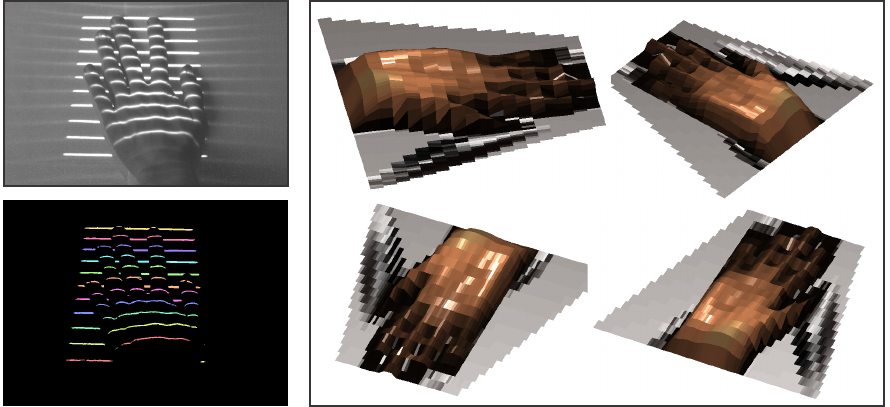
Figure 18. A visual example of the 3D reconstruction capabilities of the developed sensor. The image in the upper left corner shows a (visible light) image of the observed scene (i.e., a hand); the image in the lower left corner shows the labeled distortion map; and the image on the right shows the depth image from our ATRIS sensor from various viewing